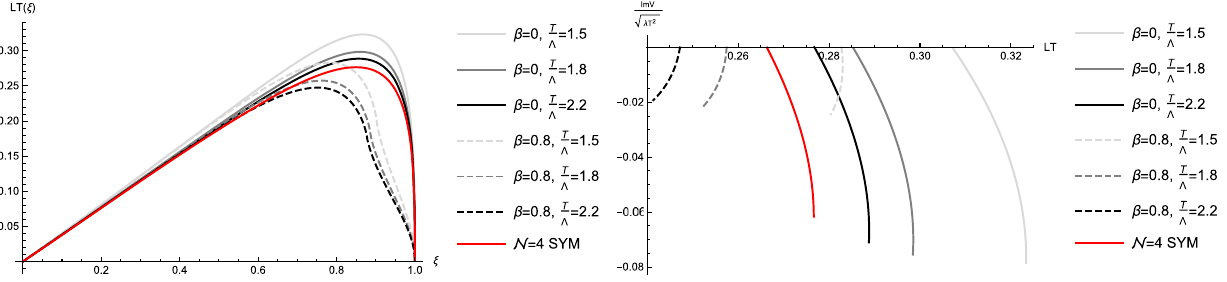
√ / λ T versus LT for different values of QQ